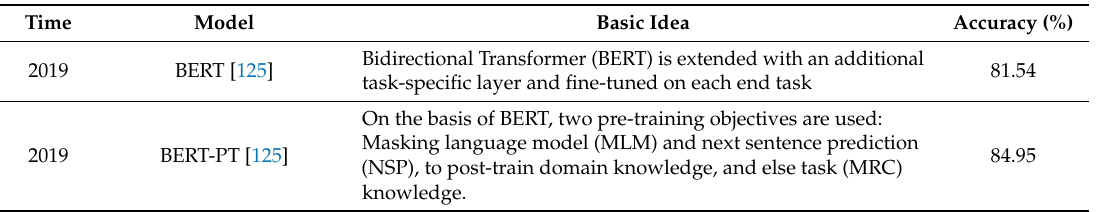
Table 5. Common aspect-based sentiment analysis (ABSA) and target-dependent sentiment analysis on subtask 1 (slot 2) SemEval 2016 Task 5 in restaurant